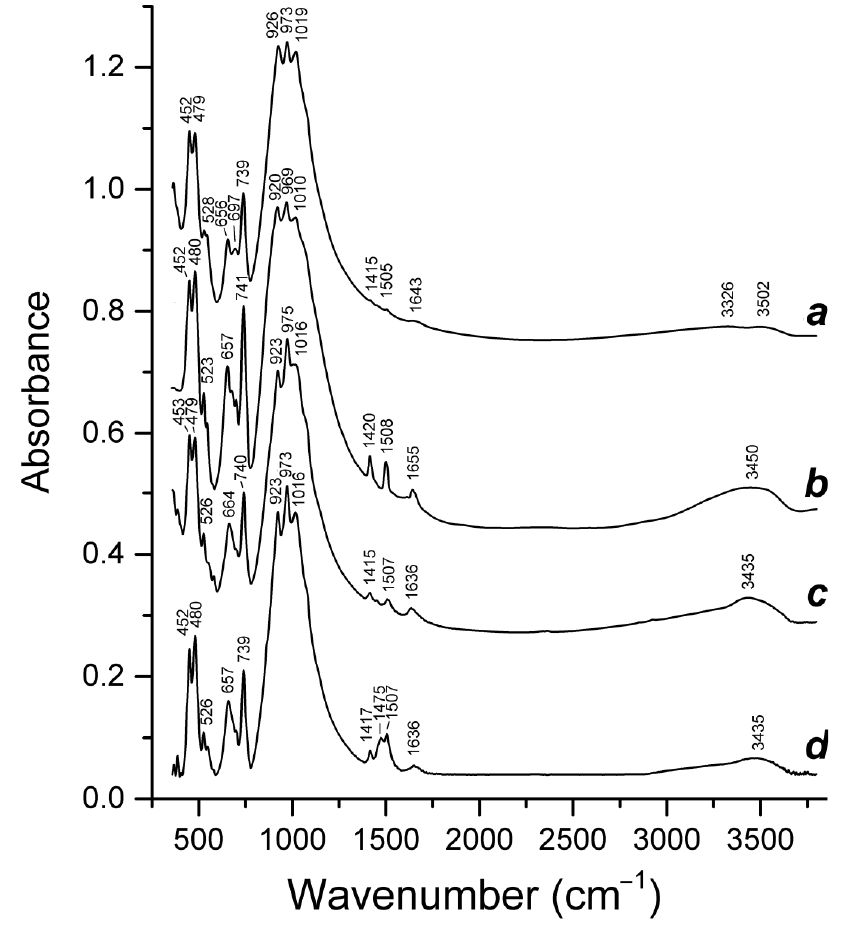
Figure 7. Powder infrared absorption spectra of ( a ) Cl-deficient taseqite from Odikhincha (this work), ( b ) CO 3 -bearing Cl-deficient taseqite with the empirical formula Na 12.0 (Sr 1.3 Na 0.9 K 0.5 Ca 0.2 Ba 0.1 )(Ca 5.7 Mn 0.3 )(Fe 1.6 Mn 1.4 )Zr 3.1 Ti 0.1 Nb 0.7 Si 25 O 73 (O,OH) x Cl 0.6 (CO 3 ) 0.5 · n H 2 O